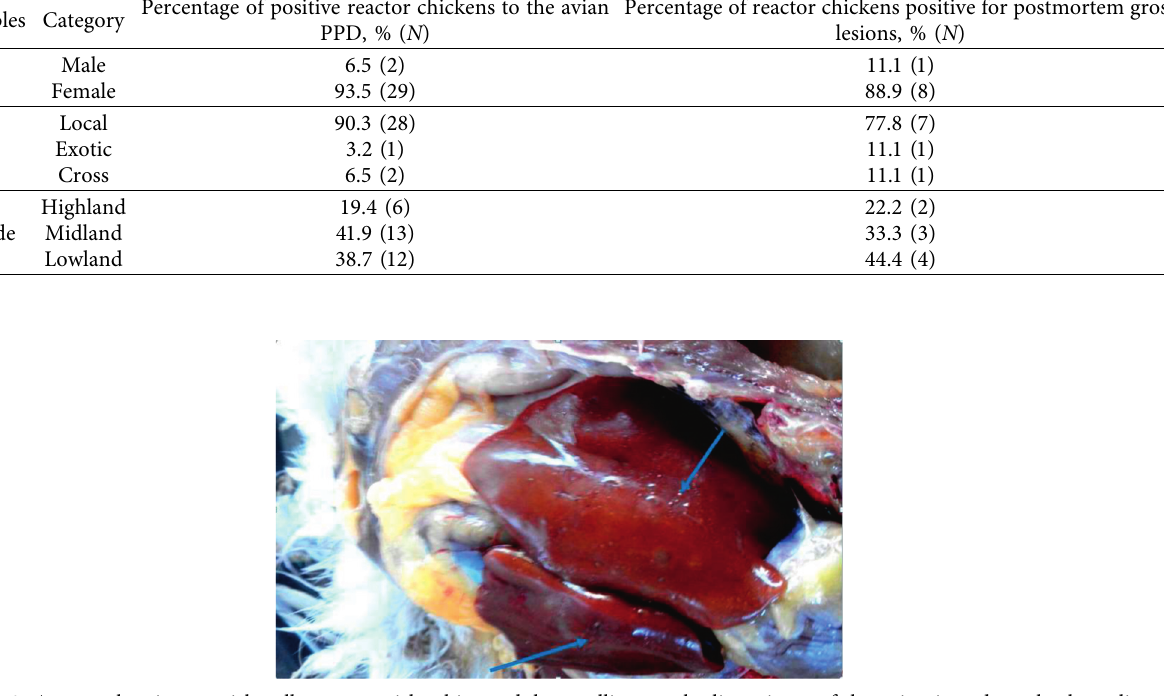
Figure 3: Arrows showing grayish-yellow to grayish-white nodular swelling on the liver tissue of the avian intradermal tuberculin test positive chicken observed upon postmortem examination.